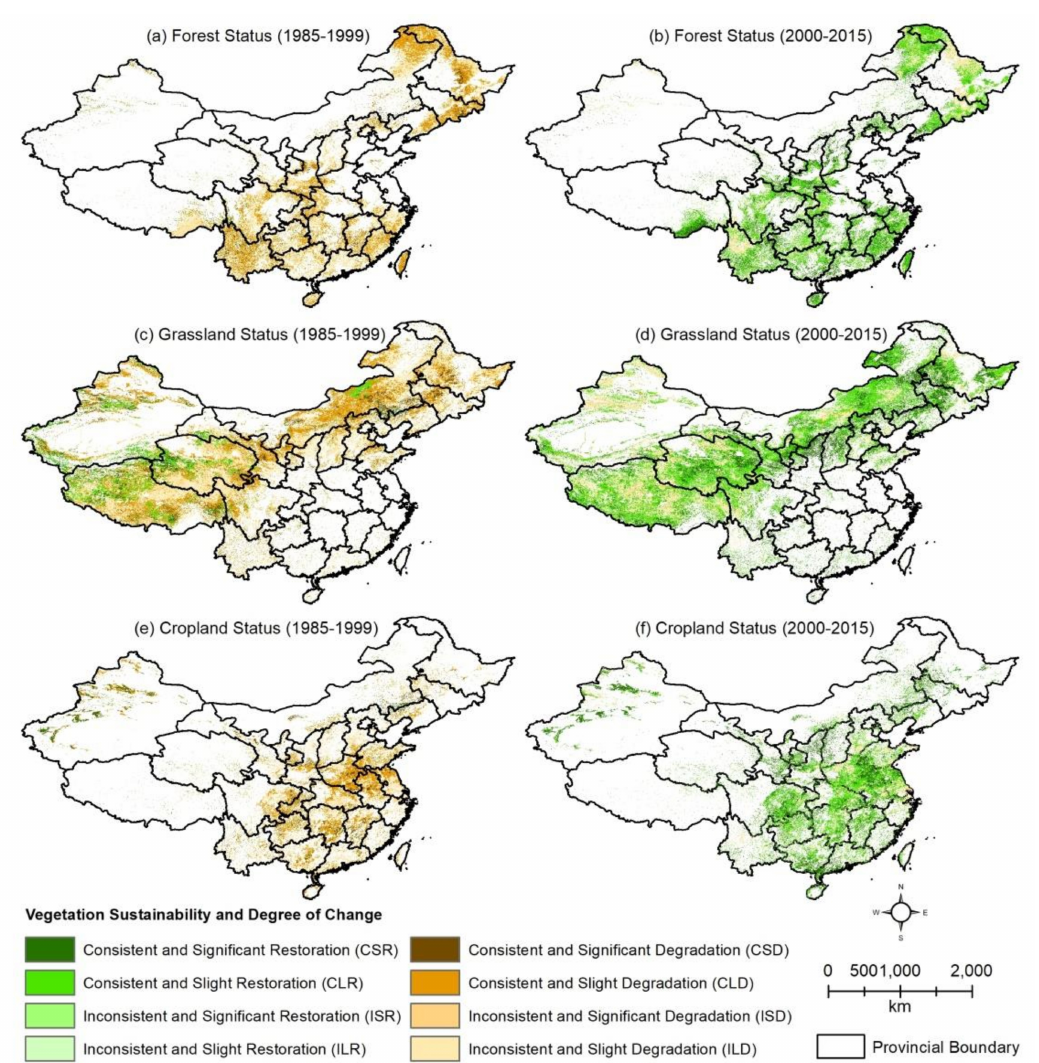
Figure 13. Spatial patterns of vegetation consistency and degree of change: ( a , b ) the spatial patterns of forestland NPP change; ( c , d ) the spatial patterns of grassland NPP change; ( e , f ) the spatial patterns of cropland NPP change for base and restoration periods,